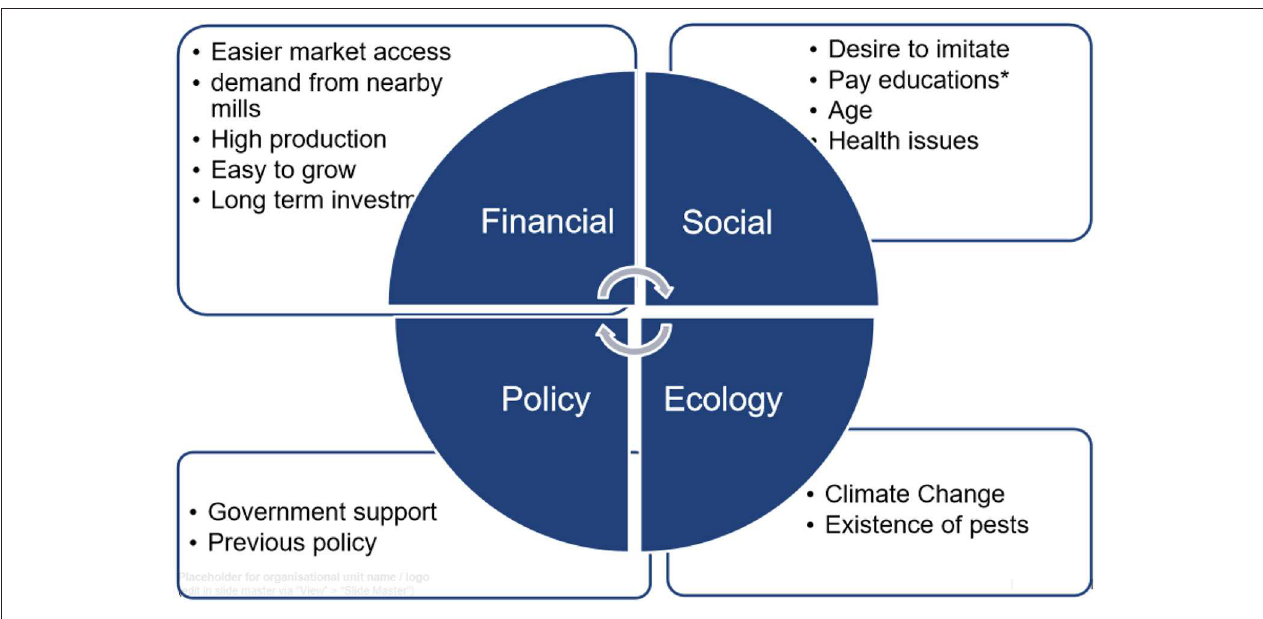
FIGURE 5 | Various reasons of villagers in Kutai Kartanegara wanting to grow palm